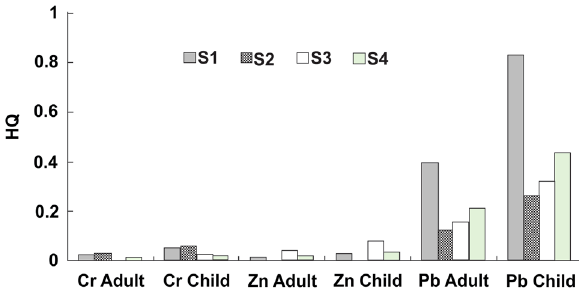
* correlation is significant at